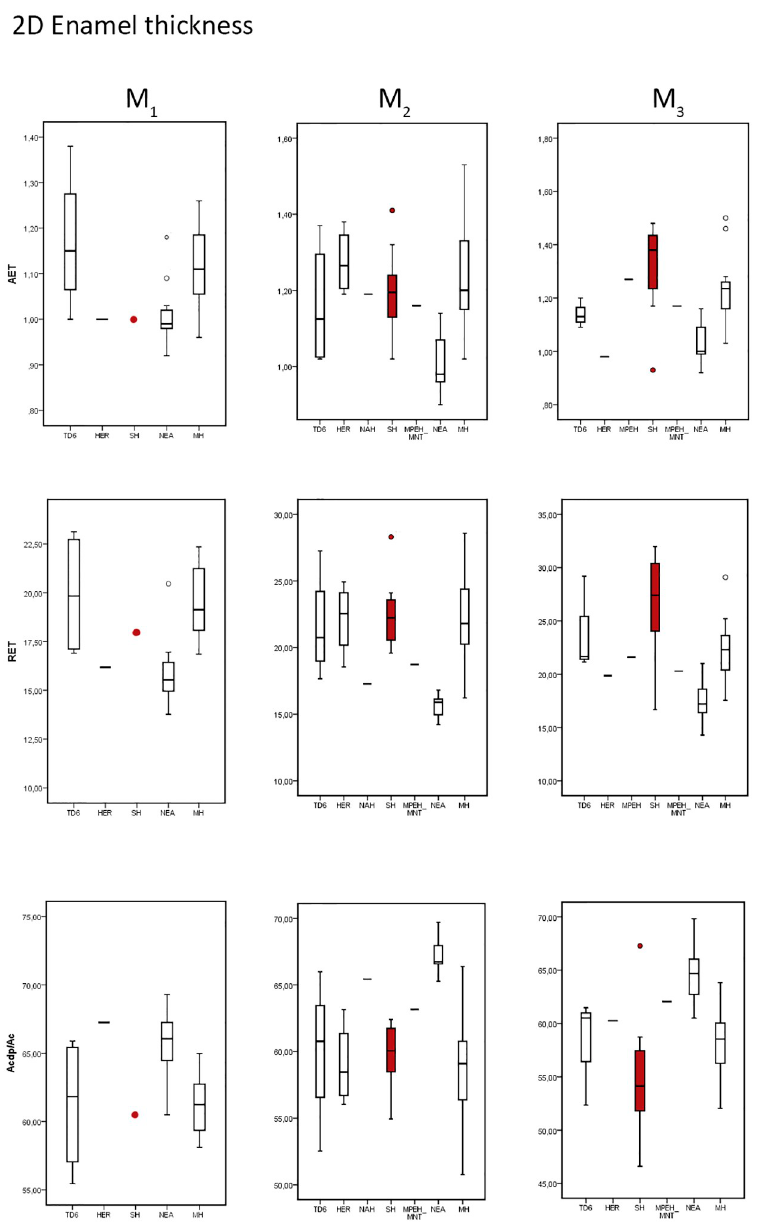
Fig 2. Box plots depicting 2D values. Values of the average enamel thickness (AET), relative enamel thickness (RET) and percentage of dentine and pulp (b/a) in the maxillary molars of the SH and the comparative specimens/samples.